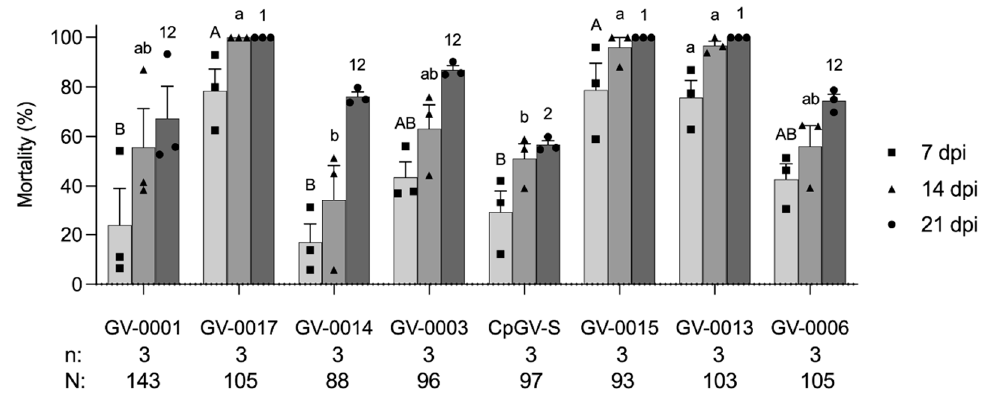
Figure 2. Mortality (mean ± standard error) of first instars of codling moth from WA3 colony exposed to eight CpGV formulations at a concentration of 6 × 10 4 OBs/mL. Mortality was recorded at 7, 14, and 21 days post infection (dpi). Each data point representing the mortality at 7, 14, and 21 dpi was plotted as a square, triangle, and circle, respectively. Data were analyzed with one-way ANOVA followed by Tukey–Kramer HSD comparison at p < 0.05. Different capital letters, lowercase letters, and numbers represent the significant differences of mortality at 7, 14, and 21 dpi, respectively. All tested individuals (N) and replicates (n) are shown below the chart.